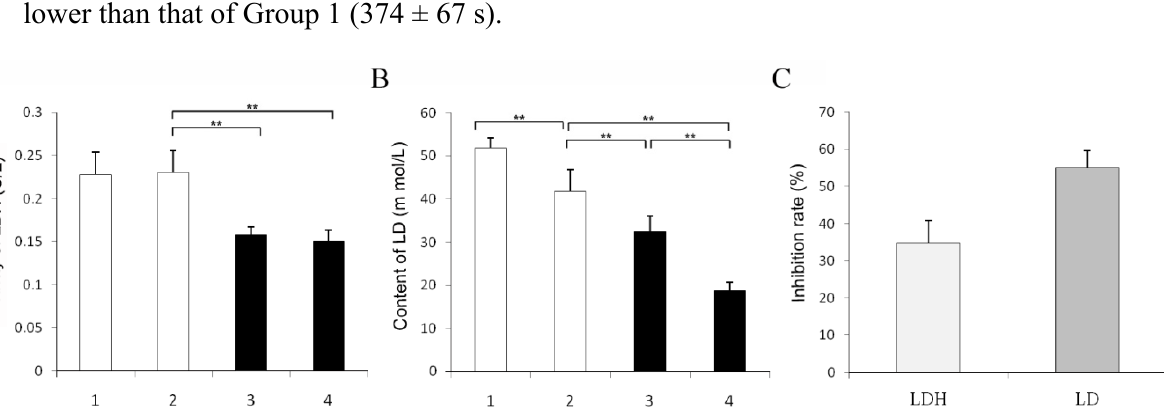
Figure 5. Swimming time of treated and untreated pikas. Group 1 pikas were injected with 0.5 mL of normal saline in each biceps femoris and swam until exhausted. Group 3 pikas were injected with 0.5 mL 1mol/L isopropyl oxamate in the biceps femoris of hind legs and swam until exhausted. All animals were forced to rest for 30 min after injection. Water temperature: 9–10 °C. All data were expressed as mean ± SD; the sample size was 10 for each group. ** p < 0.01. The average swimming time of Group 3 (284 ± 93 s) is significantly lower than that of Group 1 (374 ± 67 s).